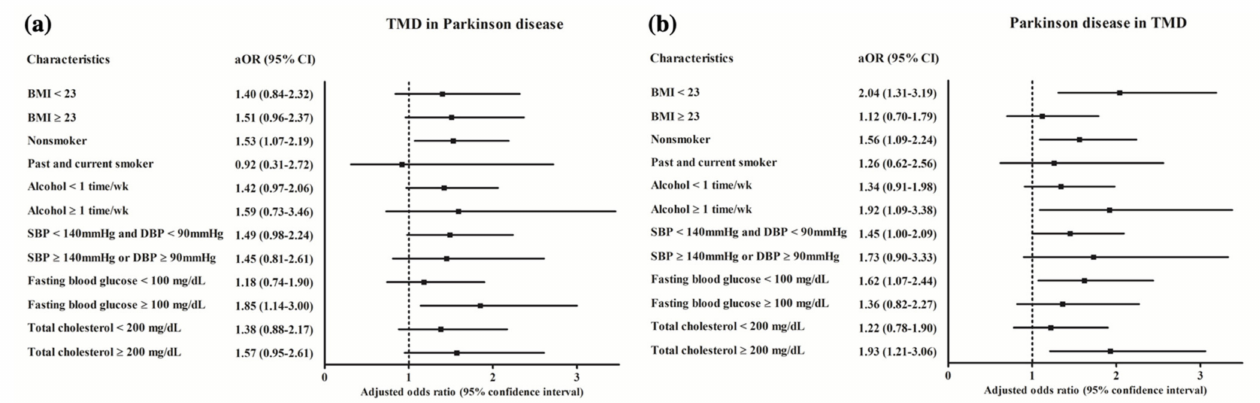
Figure 2. Subgroup analyses of ( a ) TMD in PD and ( b ) PD in TMD. TMD, temporomandibular joint disorder; PD, Parkinson’s